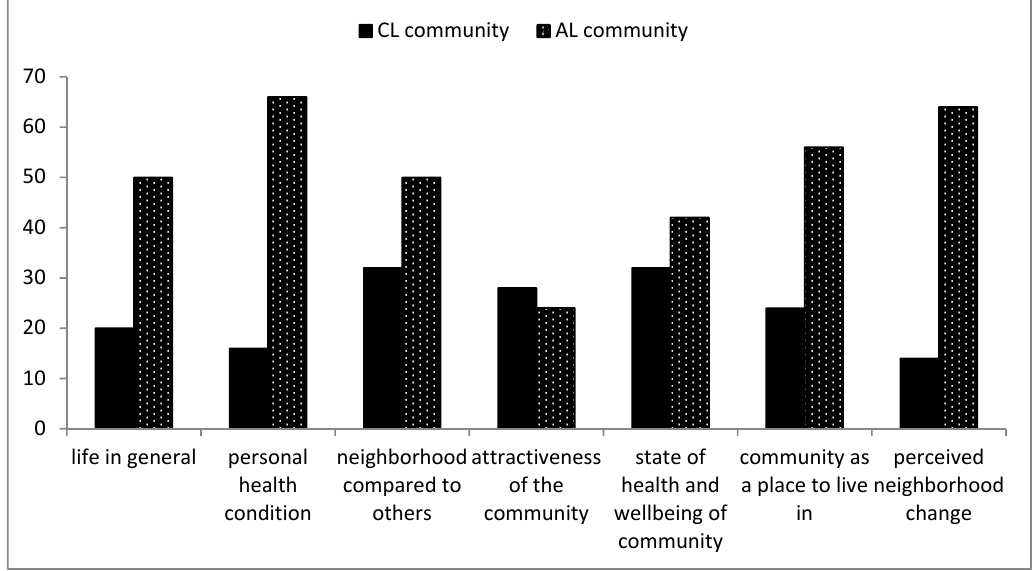
Figure 12. Comparison between both communities showing participants’ satisfaction.